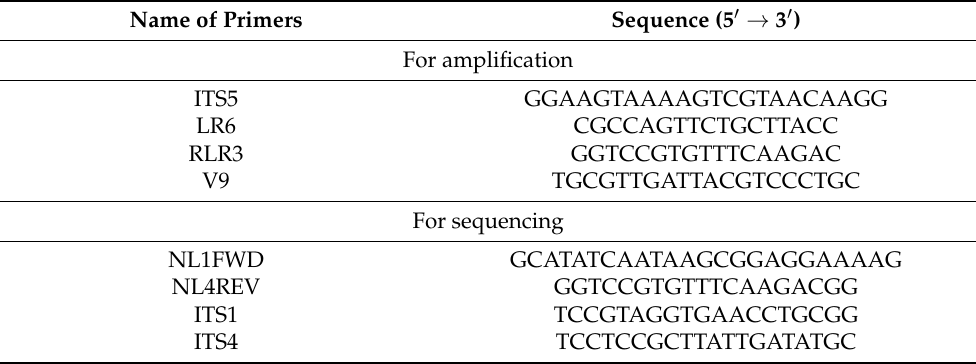
Table 1. Sequence of primers used for genetic identification of laccase producing